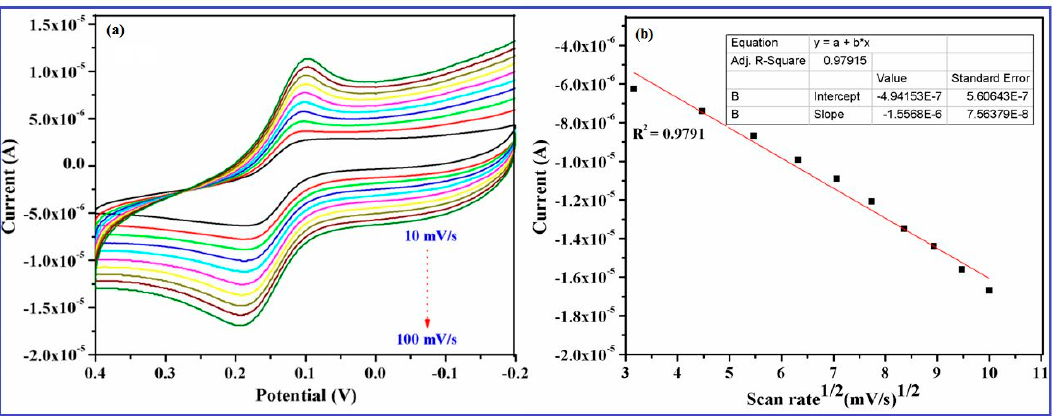
Figure 8. Cyclic voltammetric responses of CuO nanowires/GCE in the presence of 0.2 mM DA in 0.1 M phosphate buffer (pH 7.4) ( a ) at different scan rates (10 mV/s to 100 mV/s) and ( b ) calibration curve plotted versus square root of the scan rate and oxidation current.